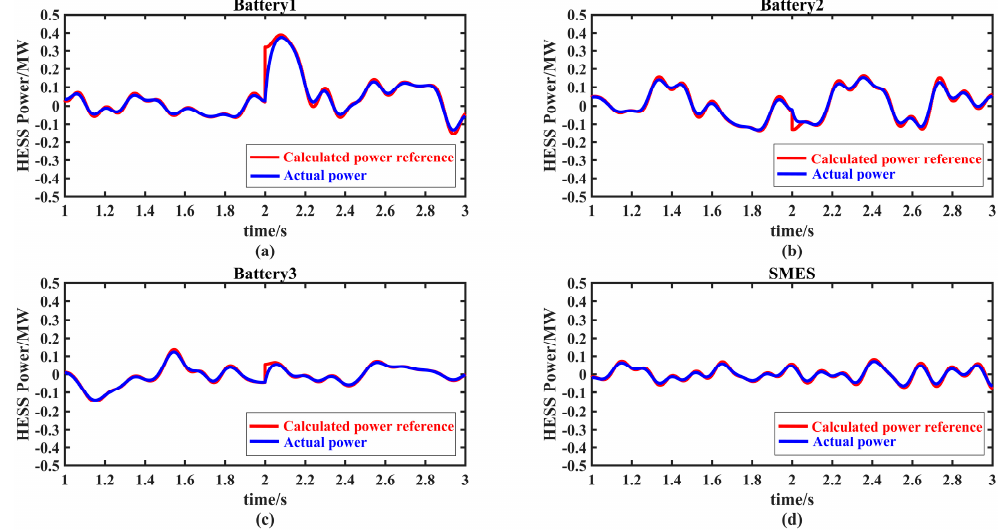
Figure 9. Calculated and actual power of the HESS. ( a ) Battery1; ( b ) Battery2; ( c ) Battery3; ( d ) SMES.